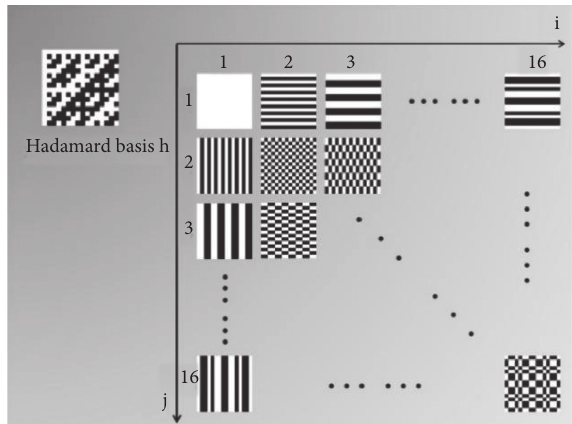
Figure 1: Schematic of the generation of a series of mask patterns based on the Hadamard matrix. The 16 × 16 Hadamard matrix is used as an example, and other orders are deduced by analogy. The white and black squares in each mask pattern represent the values of +1 and − 1,